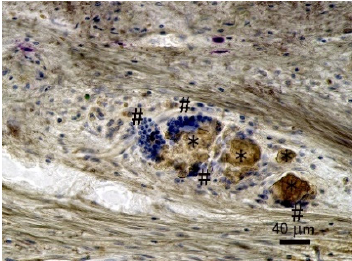
Figure 7. Magnified image of one spot from red rectangle cranial bone defect area in Figure 6a. Note: Nuclei were stained blue. Multinucleated giant cells (osteoclasts) (#) and single-nucleated macrophages were in contact with and digested fragmented remnant P-nHAP/COL particles (*).